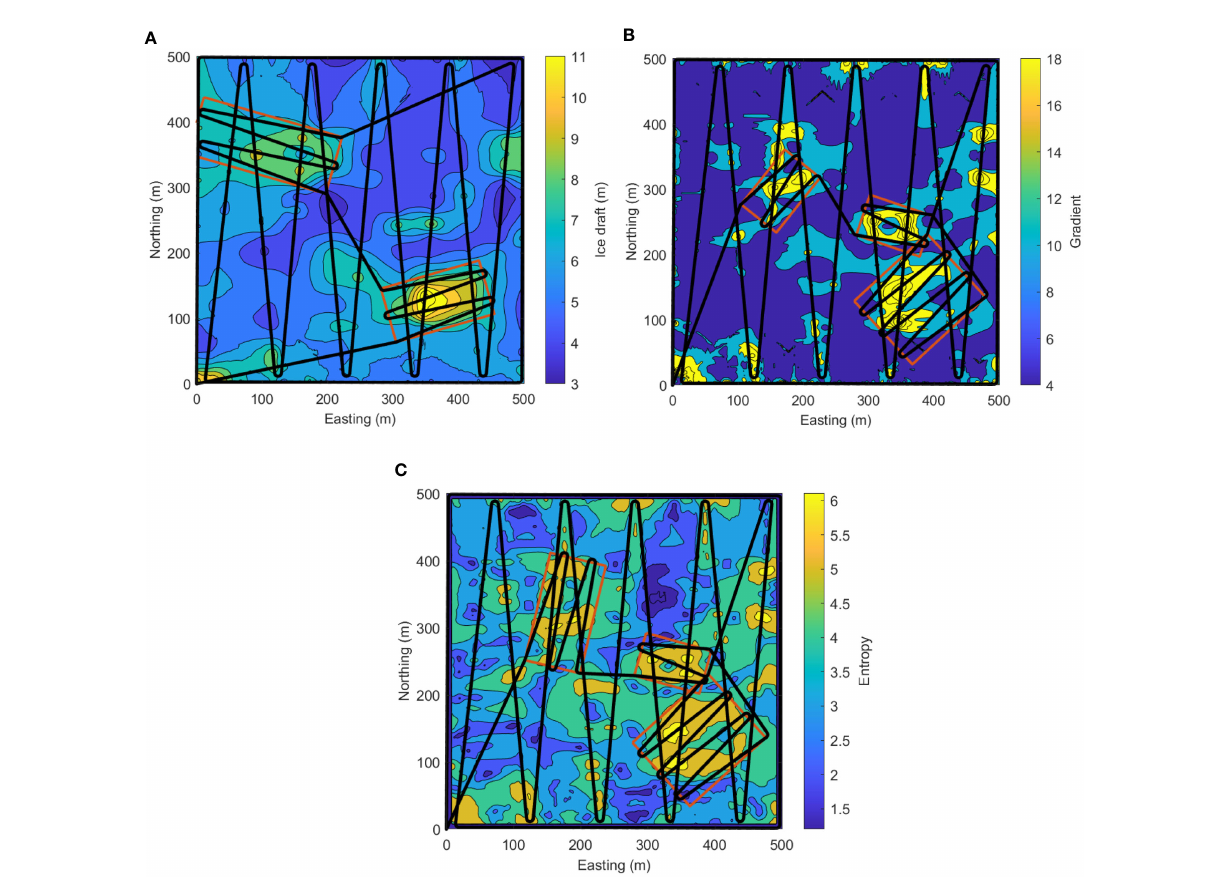
FIGURE 9 Planned trajectory for adaptive mapping under different criteria (Black solid track presents the optimized trajectory for both rough and intensive mapping). (A) Planned trajectory under ice draft criterion. (B) Planned trajectory under ice draft gradient criterion. (C) Planned trajectory under ice draft entropy